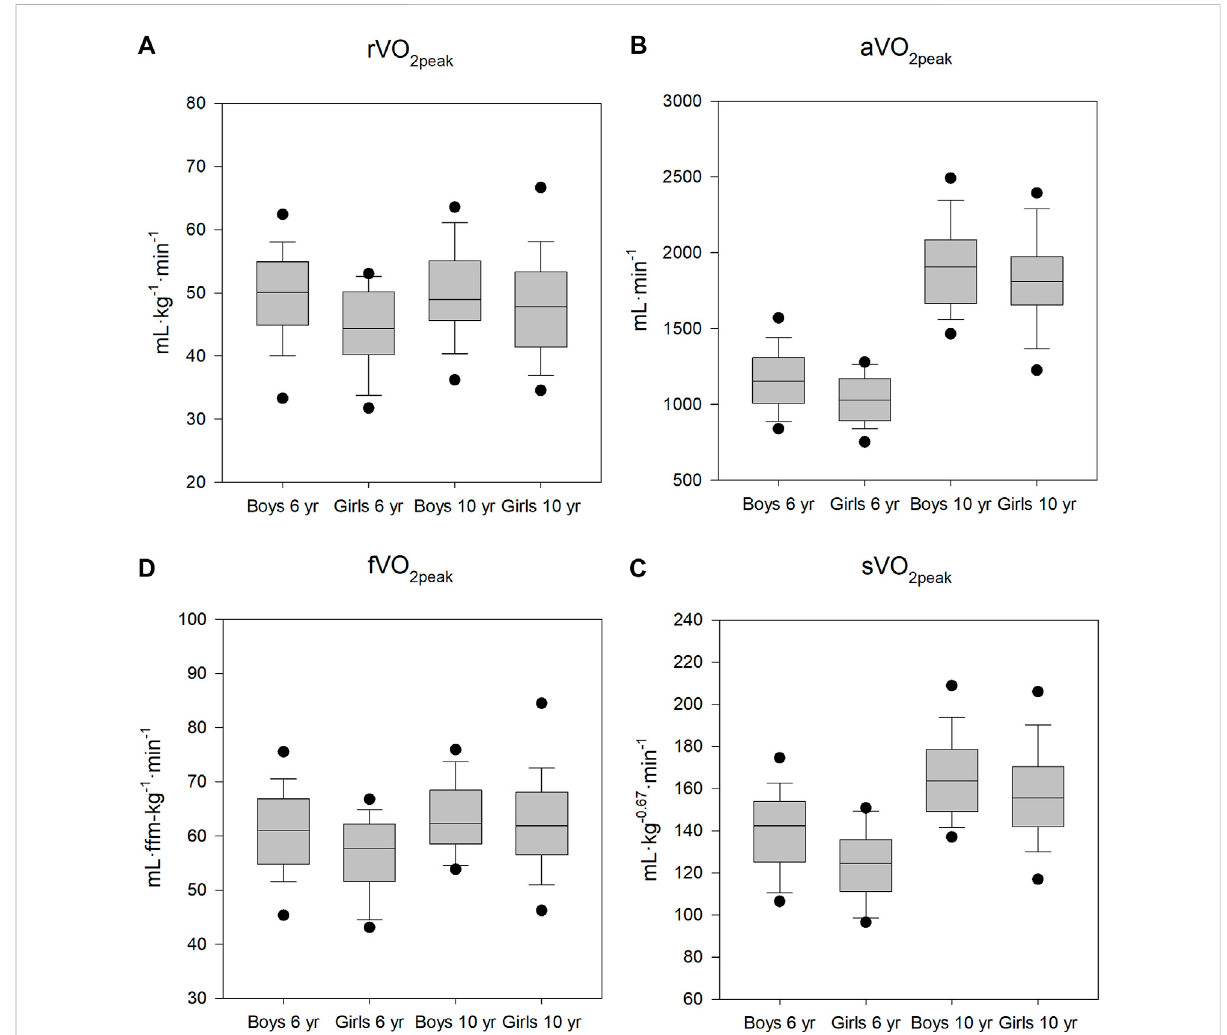
FIGURE 1 Peak oxygen uptake at ages 6 and 10. (A) : oxygen uptake relative to body mass. (B) : absolute oxygen uptake. (C) : oxygen uptake allometrically scaled (body mass − 0.67 ). (D) : oxygen uptake relative to fat-free mass. *signi fi cant differences between boys and girls ( p < 0.01). Boxes are 25 – 75 percentiles, whiskers 5 and 95 percentiles. Horizontal line is median. Dots are